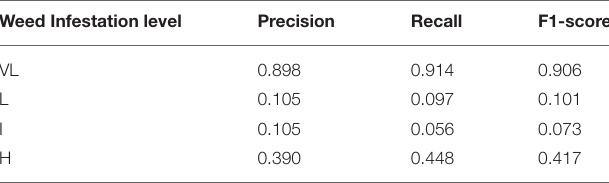
TABLE 5 | Metrics used per class to evaluate the predictive quality of IPSIM-Cirsium. Weed Infestation